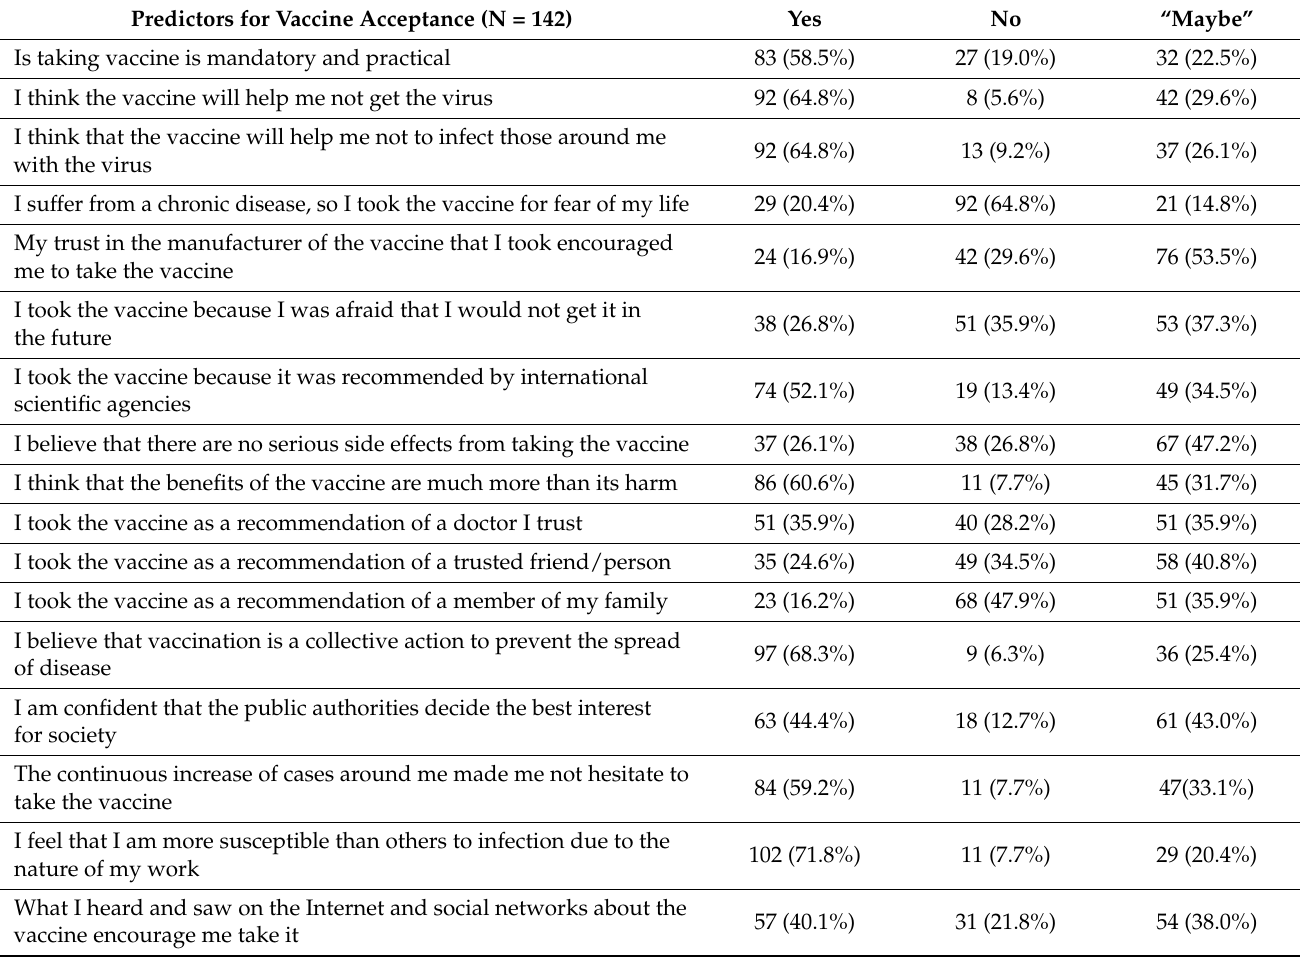
Table 2. Predictors of vaccine acceptance among accepted HCWs (N =